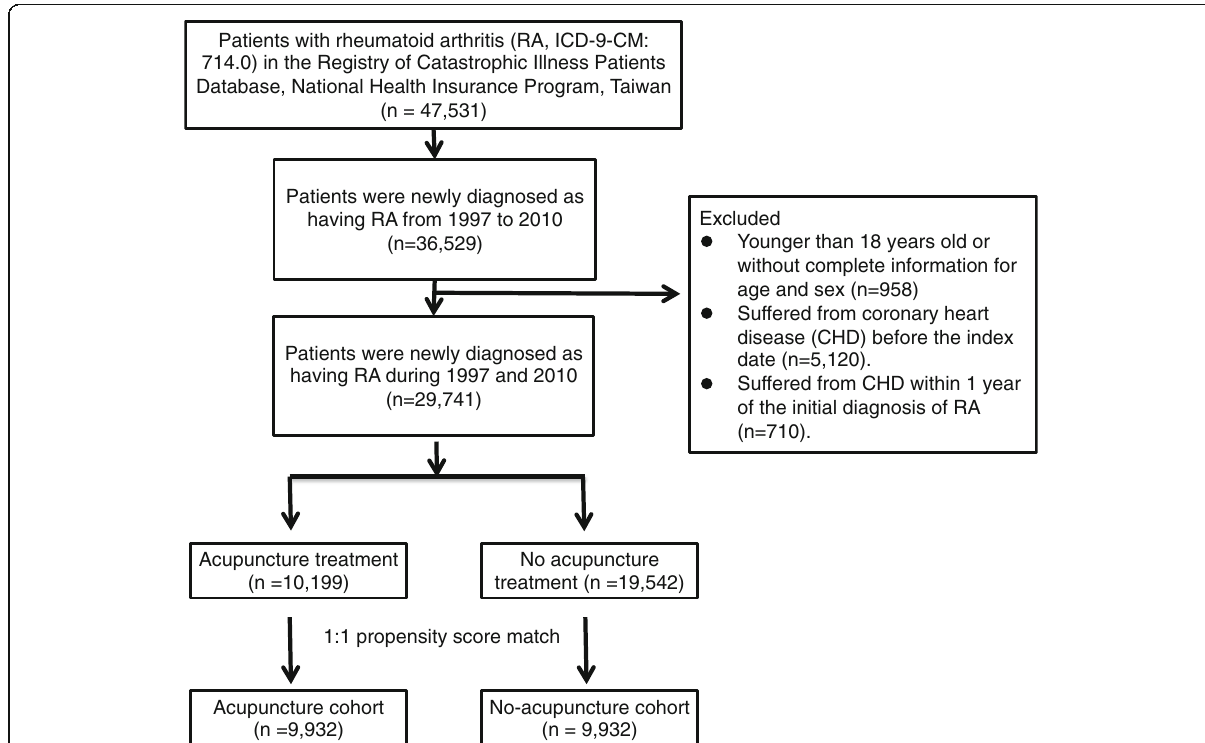
Fig. 1 Study population flowchart diagram. Using the inclusion and exclusion criteria, we identified 10,199 patients who underwent acupuncture and 19,542 patients who never underwent acupuncture. After performing 1:1 propensity score matching, there were 9932 patients in the acupuncture and no-acupuncture